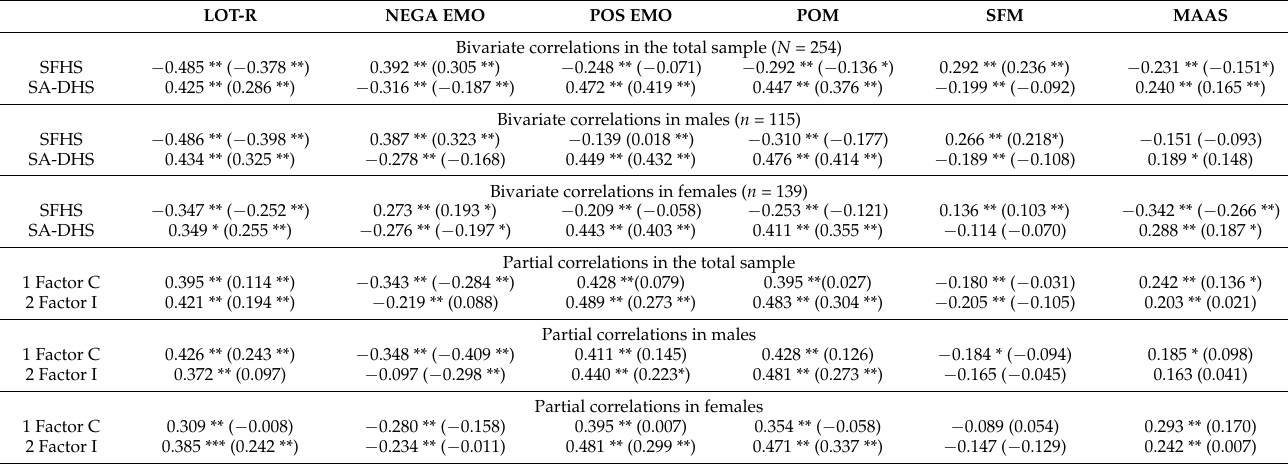
Table 5. Zero-order and partial correlations of the Subjective Authentic–Durable Happiness dimension, the Subjective Fluctuating Happiness dimension, Contentment and Inner peace dimension with various measures in Sample 2. LOT-R NEGA EMO POS EMO POM SFM